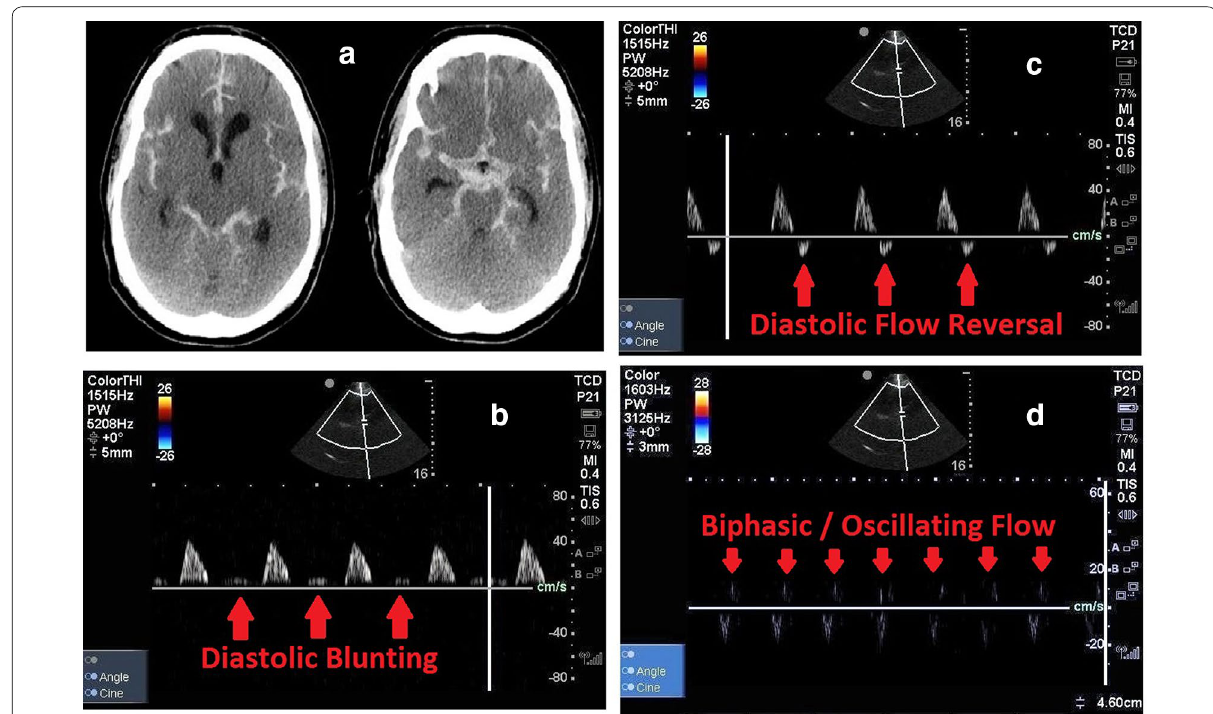
Fig. 4 Step-wise progression of cerebral circulatory arrest. a CT Head demonstrating diffuse subarachnoid hemorrhage. b Evidence of raised ICP causing decreased diastolic flow as evidenced by blunting of the spectral Doppler signal. c Further progression with diastolic flow reversal as raised ICP prevents forward flow in MCA, and even induces backwards flow. d Biphasic and oscillating flow as evidenced by net zero flow (where systolic and diastolic flow are near equal to each other), indicating the first TCD stage of cerebral circulatory